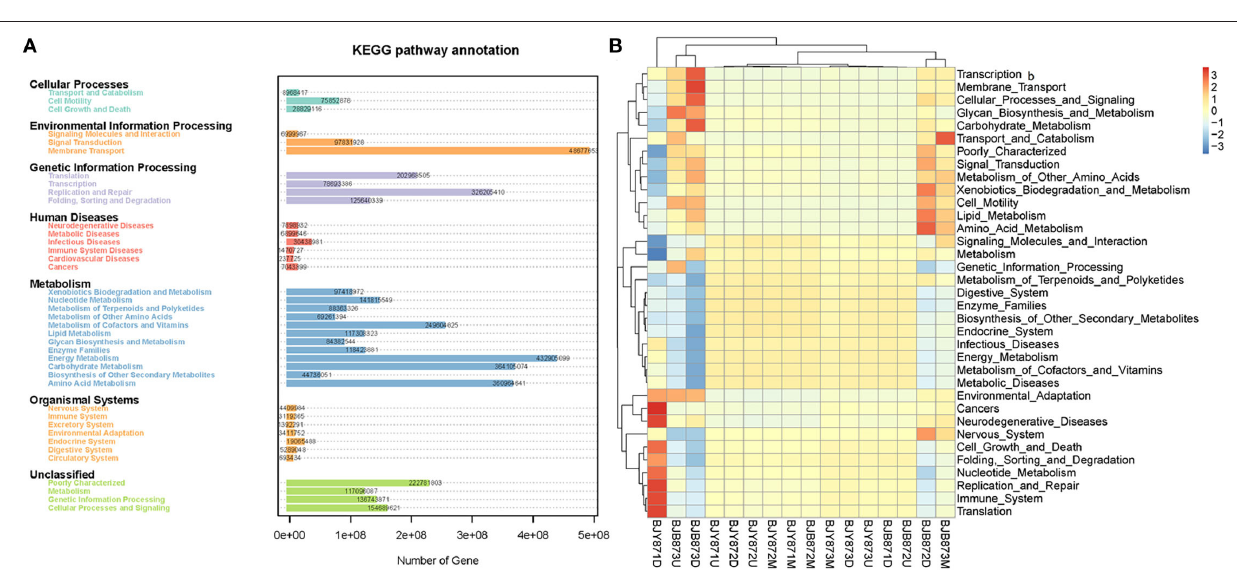
in the second stage. The relative abundance of Phoma from the same position in the same leaf type increased in three stages and had no significant difference among 9 healthy samples while it indicated a significant difference at 0.05 level in diseased samples at the lower and middle positions in the first and last stages. In terms of bacterial phyla and genera, Proteobacteria and